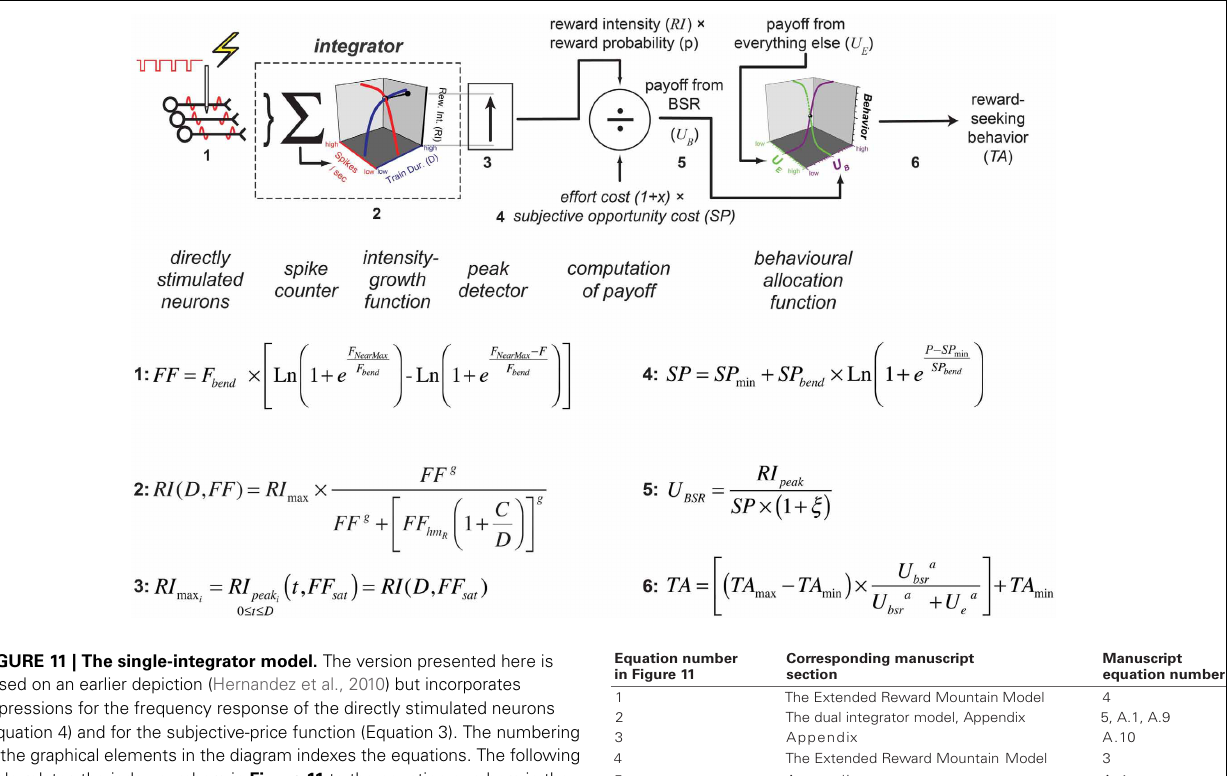
FIGURE 11 | The single-integrator model. The version presented here is based on an earlier depiction (Hernandez et al., 2010) but incorporates expressions for the frequency response of the directly stimulated neurons (Equation 4) and for the subjective-price function (Equation 3). The numbering of the graphical elements in the diagram indexes the equations. The following table relates the index numbers in Figure 11 to the equation numbers in the main text and